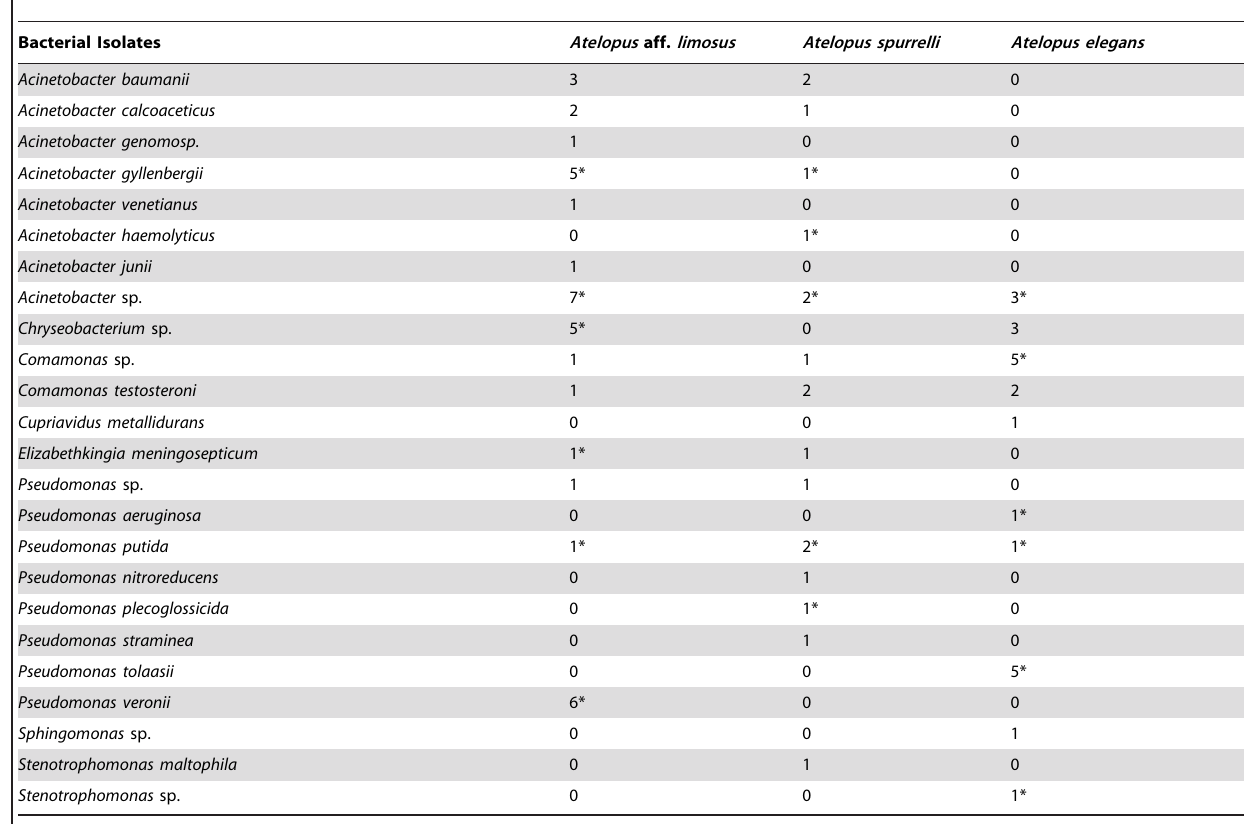
Table 1. Prevalence of bacterial species isolated from the skin of Atelopus aff. limosus, A. spurrelli and A. elegans .